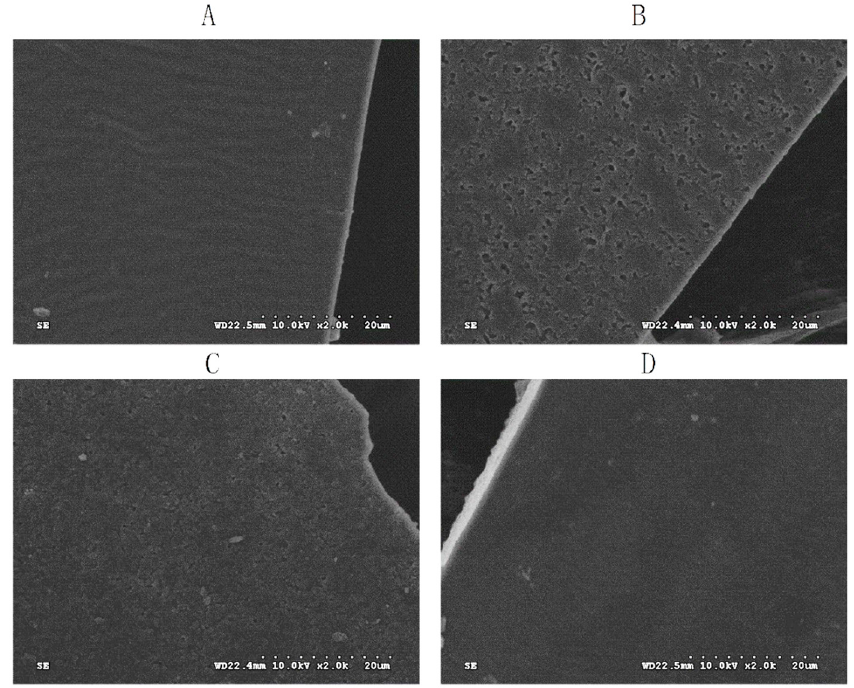
Figure 2. SEM of the surface (× 2000) of CS ( A ), PA-g-CS-I ( B ), PA-g-CS-II ( C ), and PA-g-CS-III ( D )